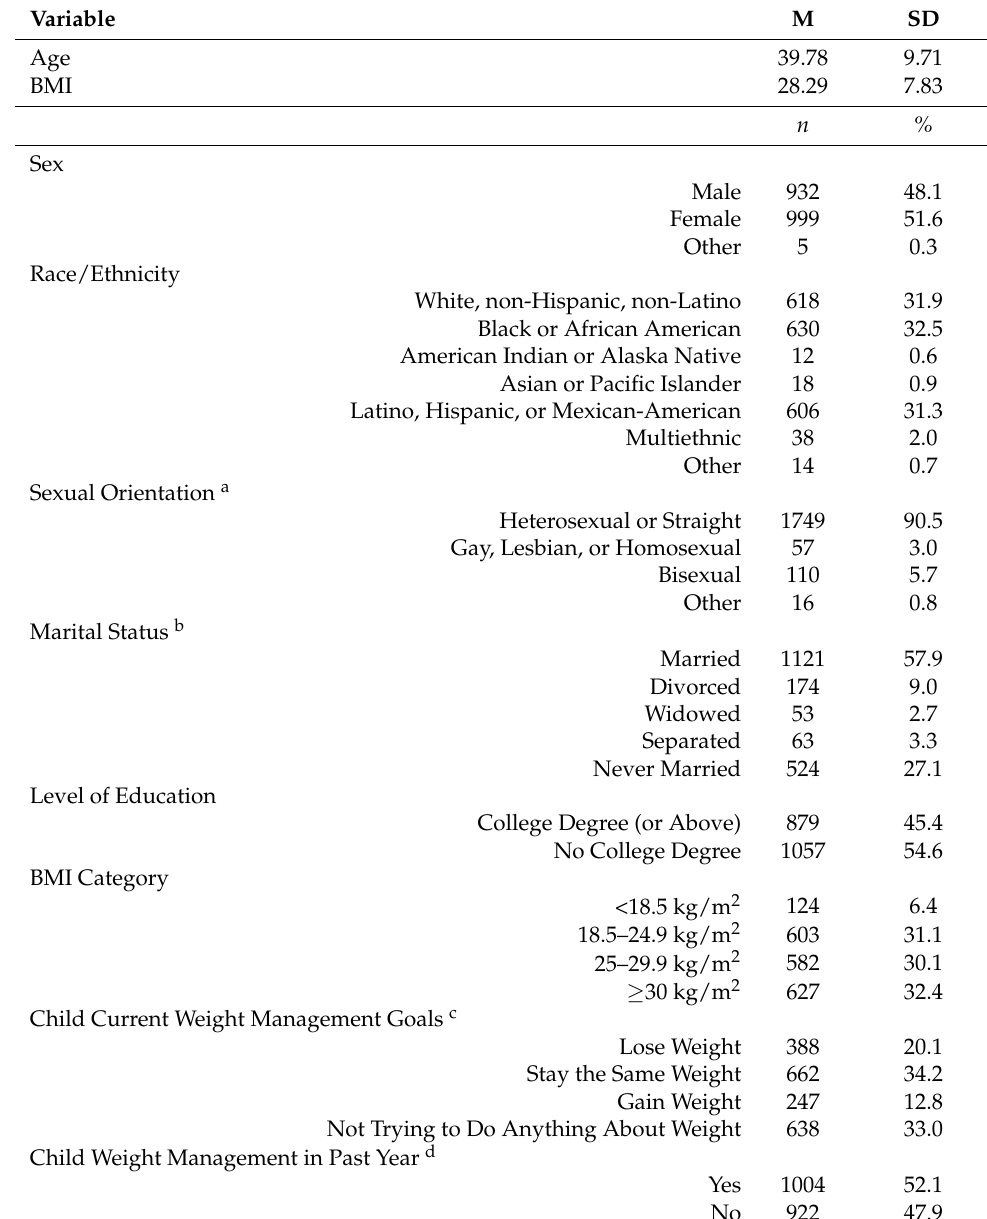
Table 1. Demographic and anthropometric information for the parent sample ( n =